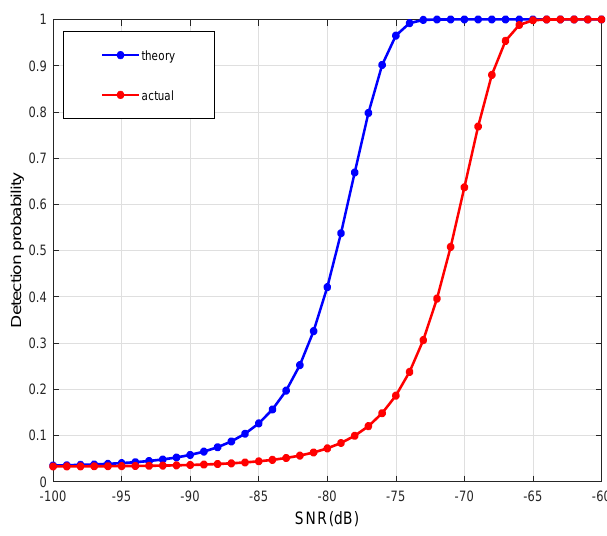
Figure 7. Relationship between SDR and detection performance.